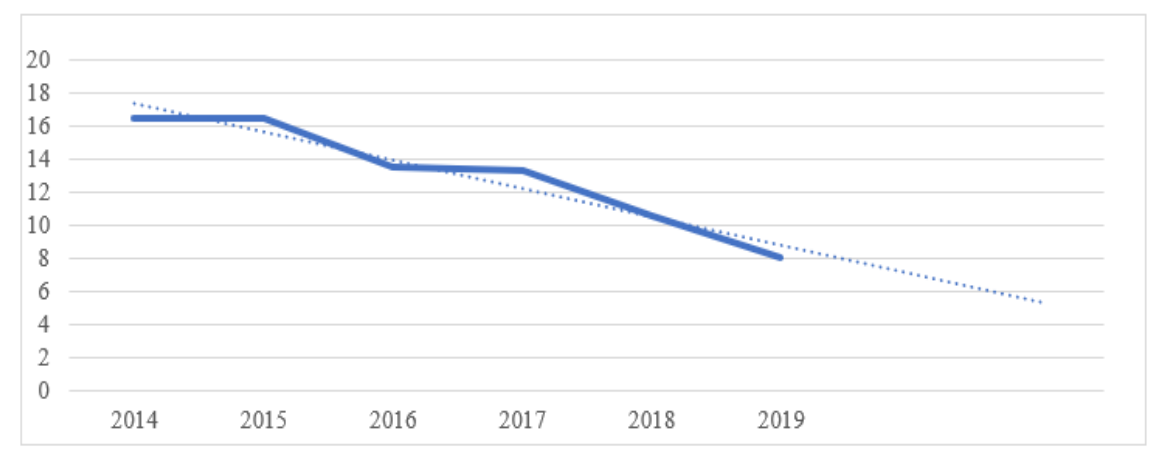
Figure 5. Average amount of emissions produced per monetary unit. Own processing.